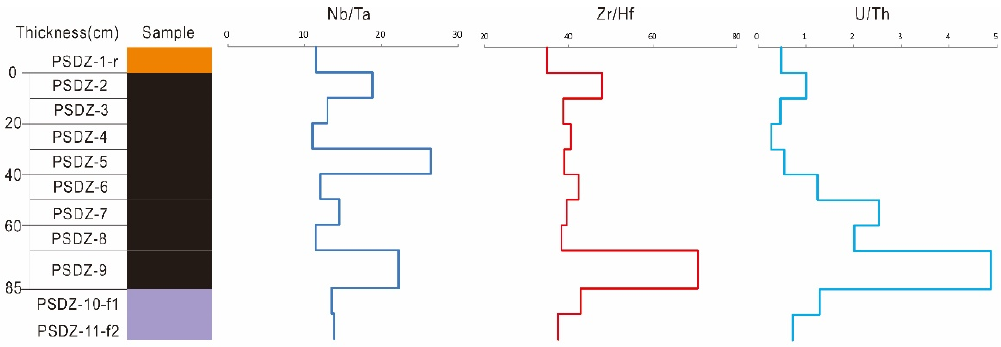
/ Ta, Zr / Hf and U / Th ratio variations in coal seam profile from the Dongzhou mine. Minerals 2020 , 10 , x FOR PEER REVIEW